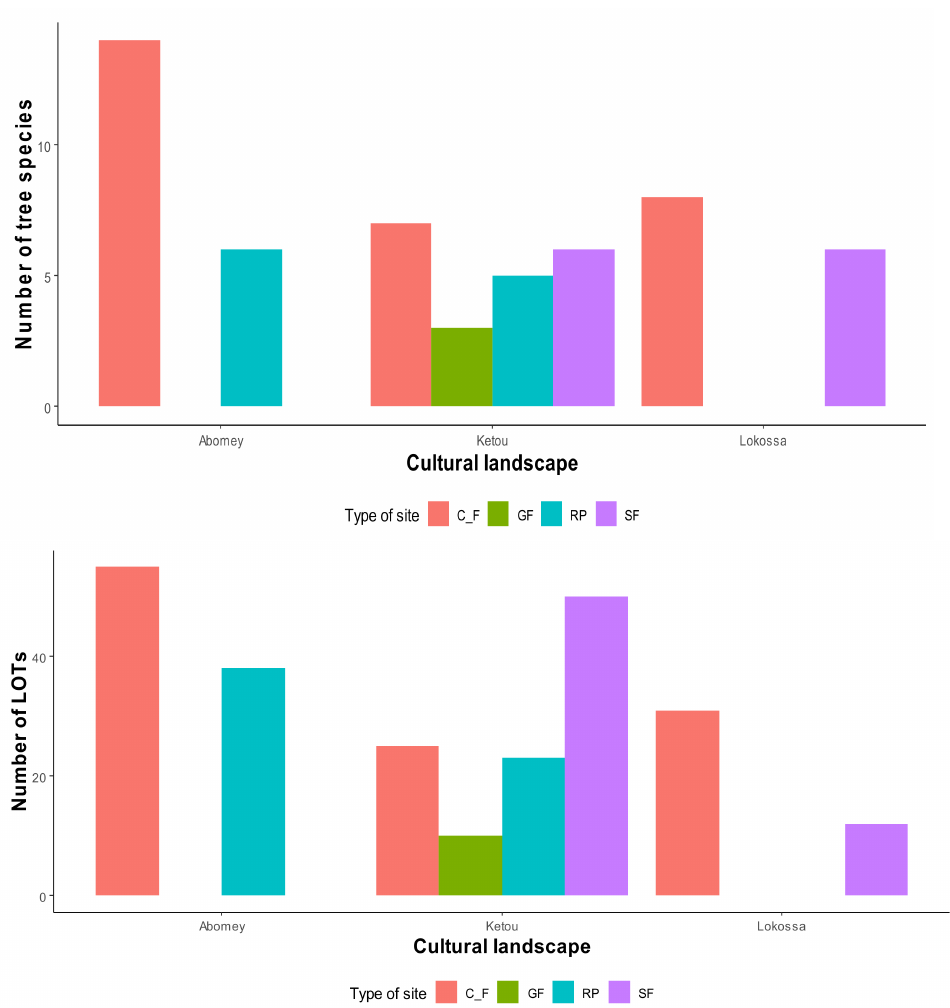
Figure 2. Proportion of LOTs in particular types of sites for each district. Legend: C_F: Collective family space; GF: Gazetted Forest; RP: Royal palace; SF: Sacred forest. NB: Not all types of sites existed in all districts, e.g., ‘royal palaces’ were absent from the district of Lokossa.